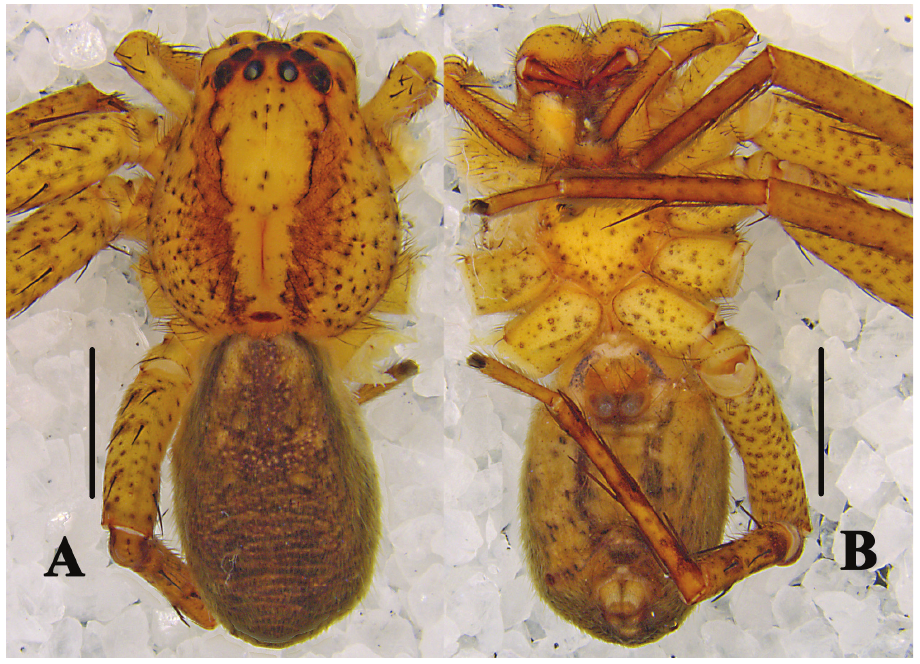
Figure 7. Pseudopoda physematosa sp. nov. Female habitus ( A dorsal B ventral). Scale bars: 2